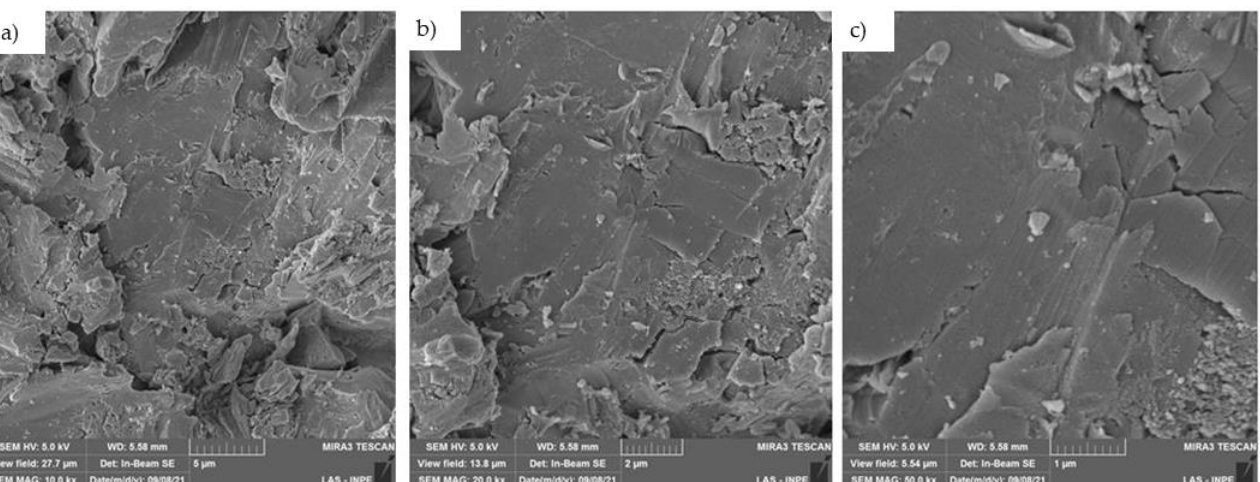
Table 2. One-way ANOVA for the fracture load between the long universal link group and the short universal link group.